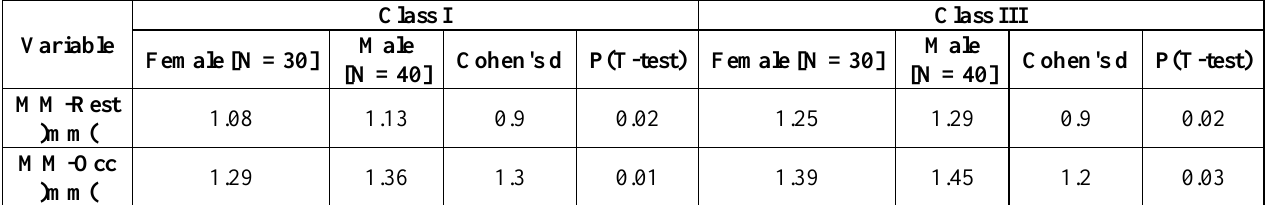
Table 6: Effect of Skeletal Relationships on MM Thickness Stratified by Gender